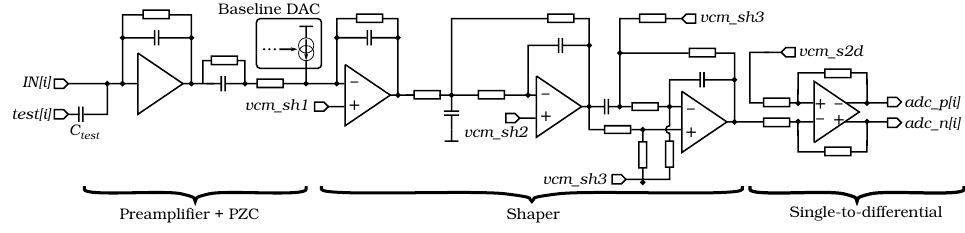
Figure 2. Simplified block diagram of analogue